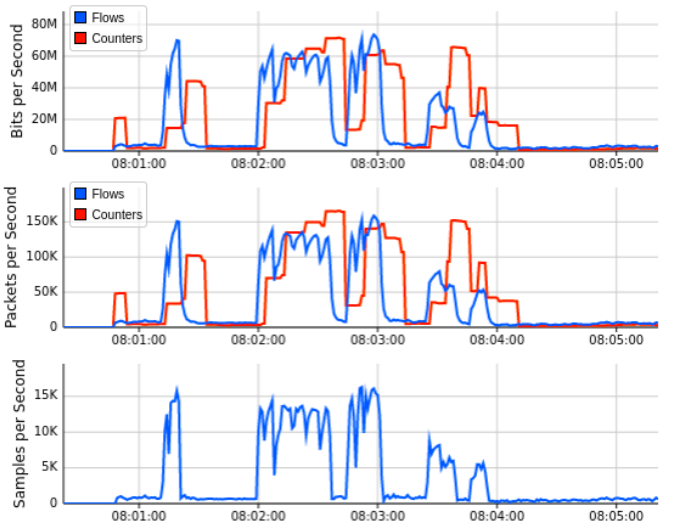
Figure 17. Network bandwidth dashboard during real-time DDoS attacks (T2).